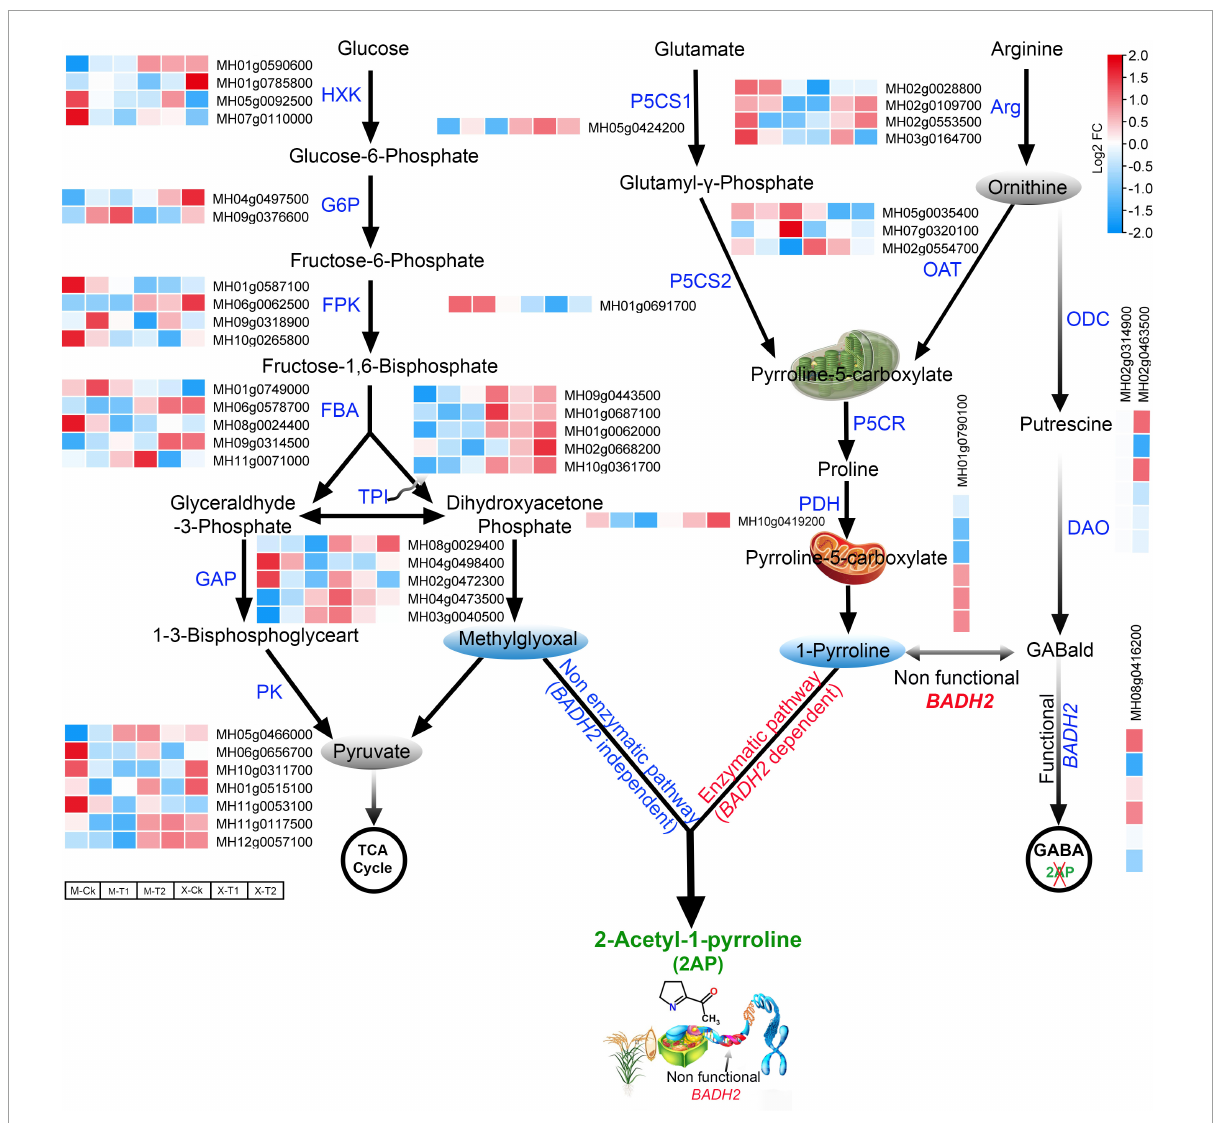
FIGURE4 Schematic representation and gene expression summary of 2-AP biosynthesis pathways related genes in Meixiangzhan-2 (M) and Xiangyaxiangzhan (X) cultivars in response to different levels of Zn treatment. Blue, white, and red indicate low, no and high gene expression,